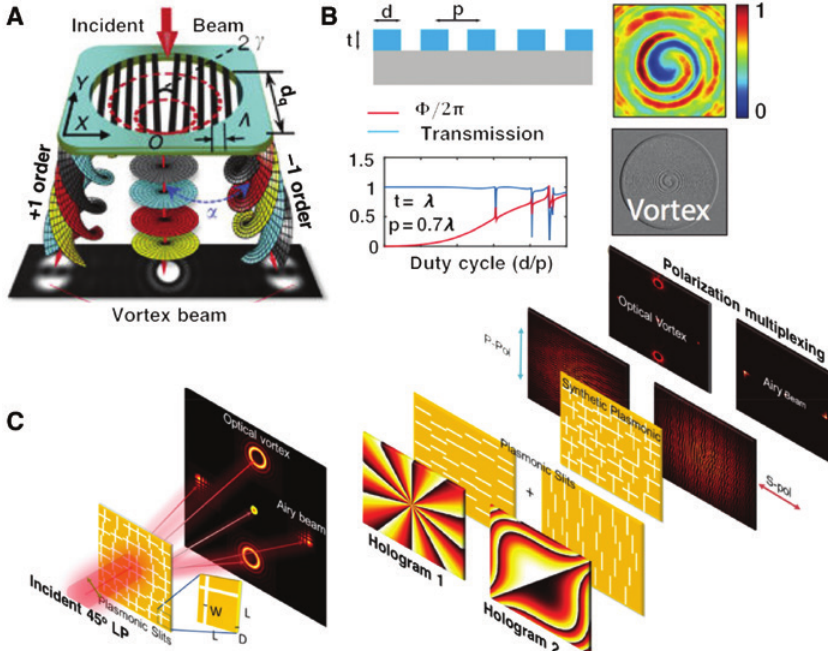
Figure 2: Optical vortex beam generated by metasurface holograms. (A) Sketch of the metasurface fork grating hologram with an open circular aperture generates different optical vortices depending on the size of the aperture. Reprinted from Ref. [110]. (B) A spiral metasurface hologram composed of silicon nitride nanorods generates an optical vortex with topological charge ℓ = 1. A full phase control implemented by tuning the coupling strength of adjacent scatters via tuning the duty cycle. Reprinted from Ref. [111]. (C) Schematic of the design of a multifunctional metasurface hologram based on orthogonal nanoslits that generates optical vortices and Airy beams simultaneously. Reprinted from Ref.